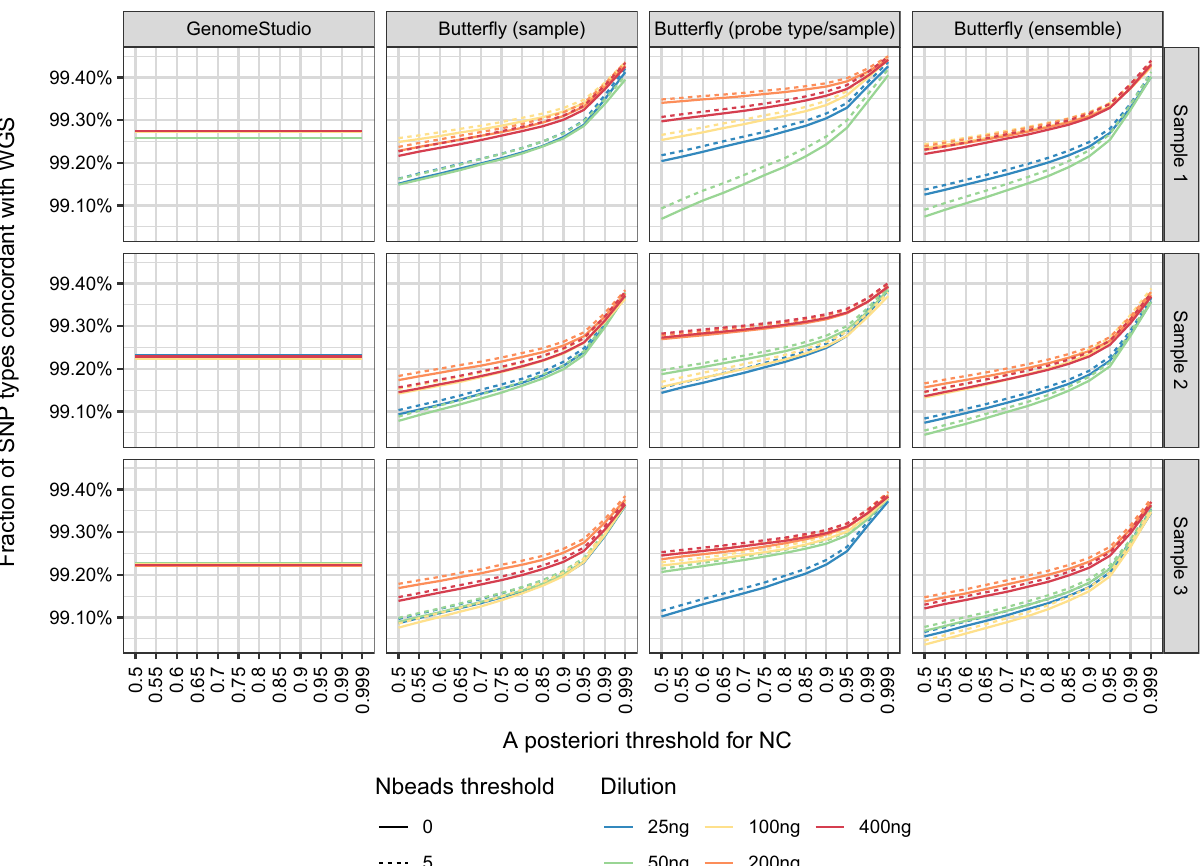
Figure 6. Concordance of SNP calls obtained with WGS, GenomeStudio, and the butterfly method for various DNA dilutions. Only SNPs with SNP calls by all methods were included. The figure is based on the same data as Fig. 5 but presented such that it is easier to compare the various DNA dilutions. The concordances were above 99% for all